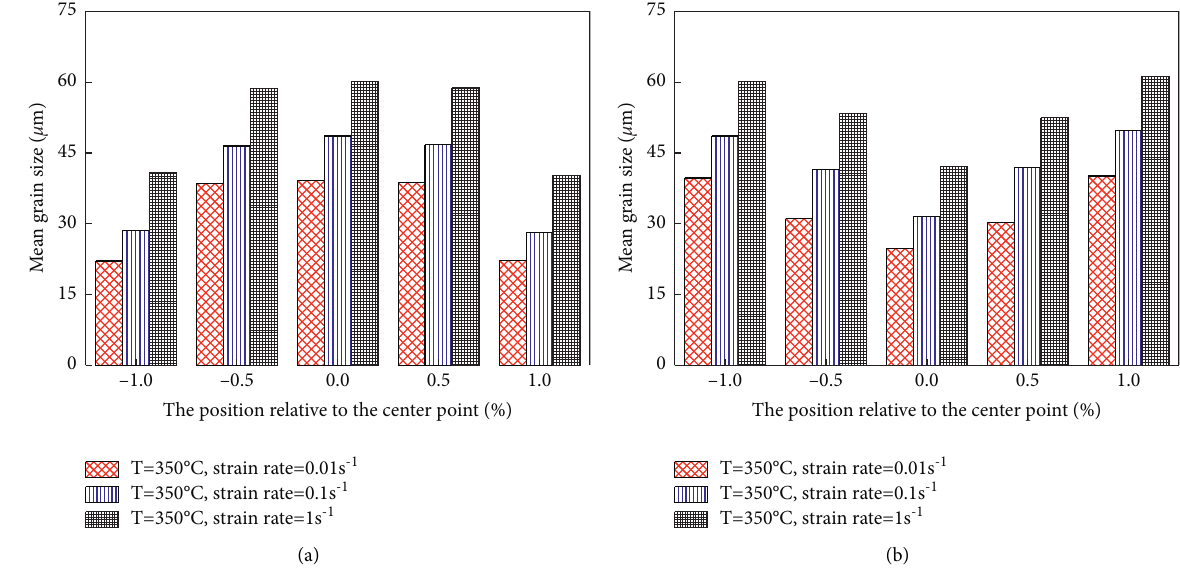
Figure 7: The grain size distribution along radial (a) and axial (b) directions of the cylinder with different compressive strain rates.